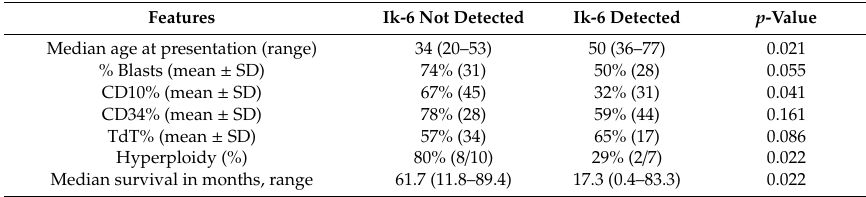
Table 2. Clinicopathologic correlations between Ik-6 and non-Ik-6-expressing ALL.